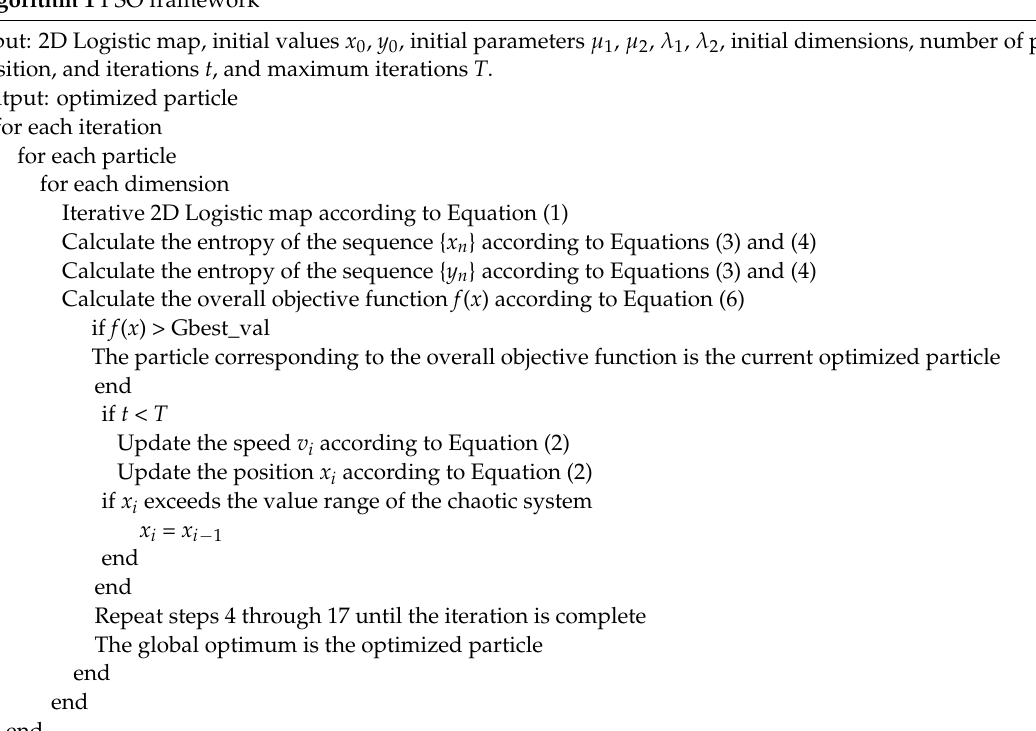
Algorithm 1 PSO framework